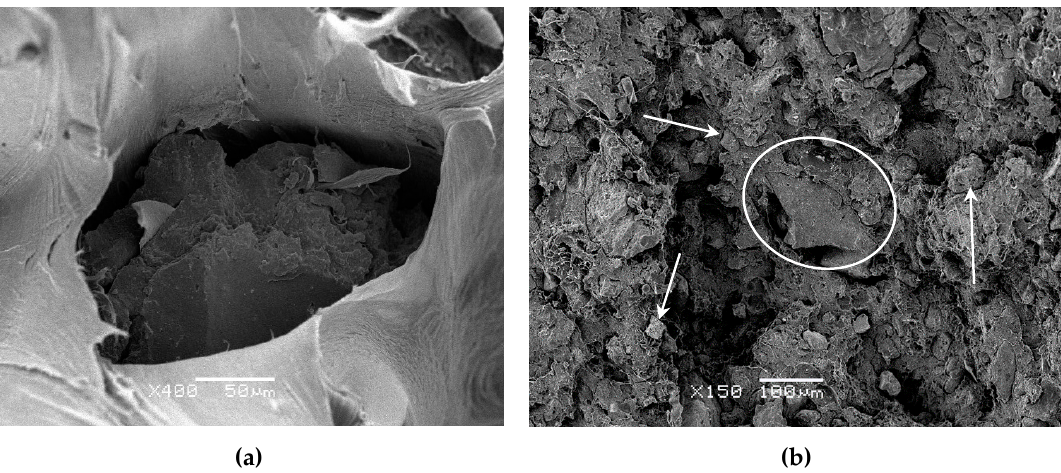
Figure 3. Scanning Electron Microscopy (SEM) micrographs of LLDPE/20%GTR compounds: ( a ) a magnification of 400 and ( b ) a magnification of 150 that shows the dispersion of small particles (arrows) and lack of compatibility large particles